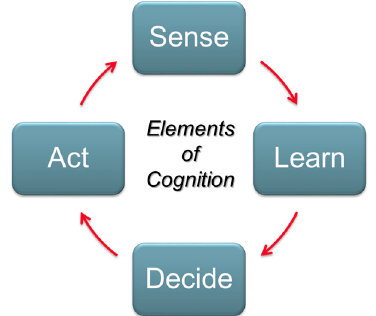
Figure 2. The cognitive loop, where “Sense” relates to the collecting and processing of radar data, “Learn” is the understanding of the environment and may include information from trusted sources, “Decide” is the determination of the optimization of the radar, and “Act” is the modification of the radar parameters to meet the mission objectives in the known environment.